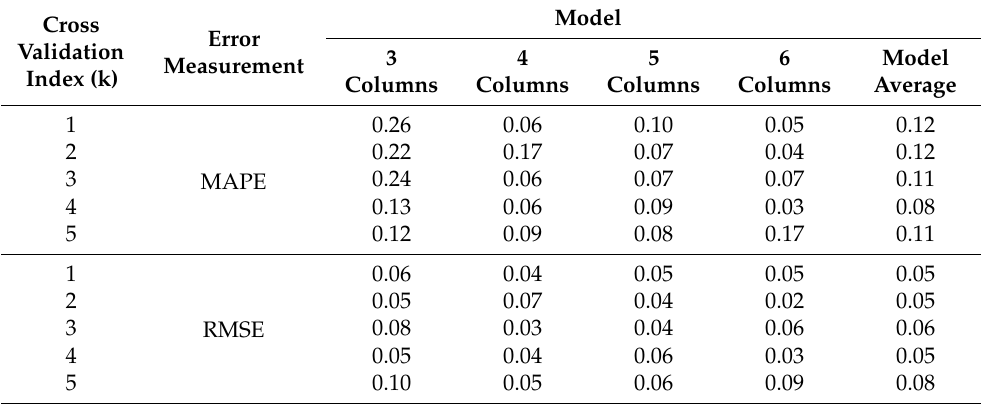
Table 7. Root Means Square Error (RMSE) and Mean Absolute Percent Error (MAPE) for the Gaussian process prediction for each cross validated data set.